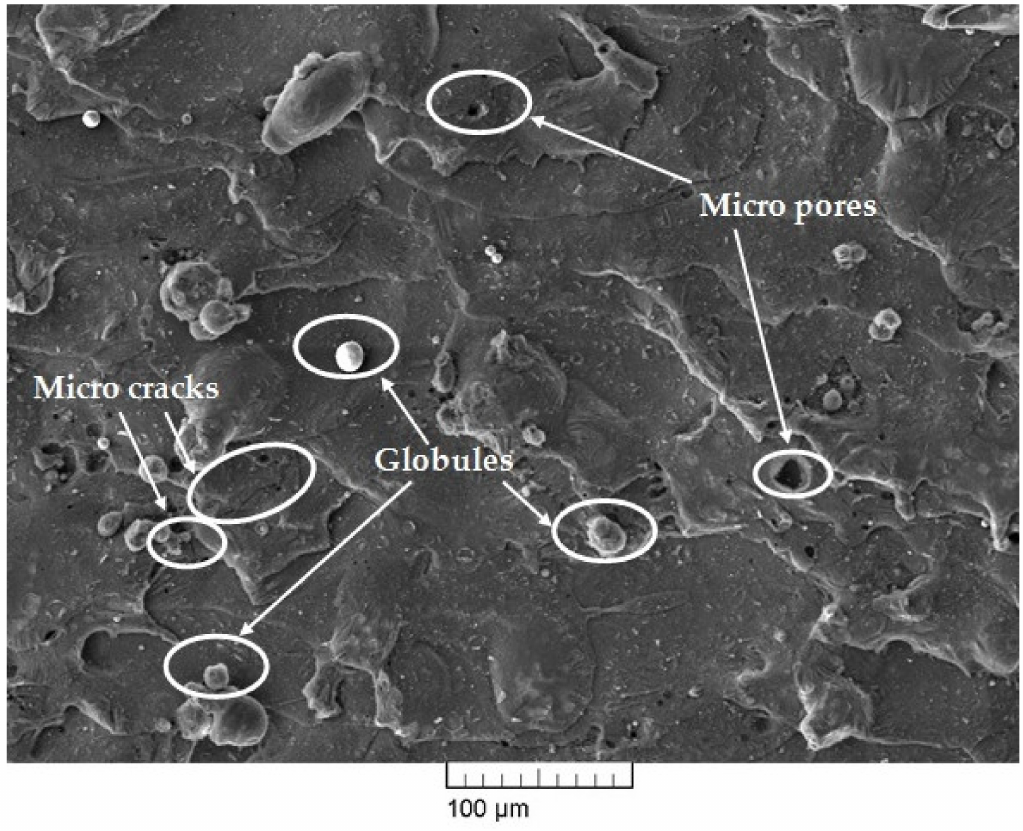
Figure 7. Scanning-electron-mircroscope (SEM) micrograph of machined surface obtained at high discharge-energy